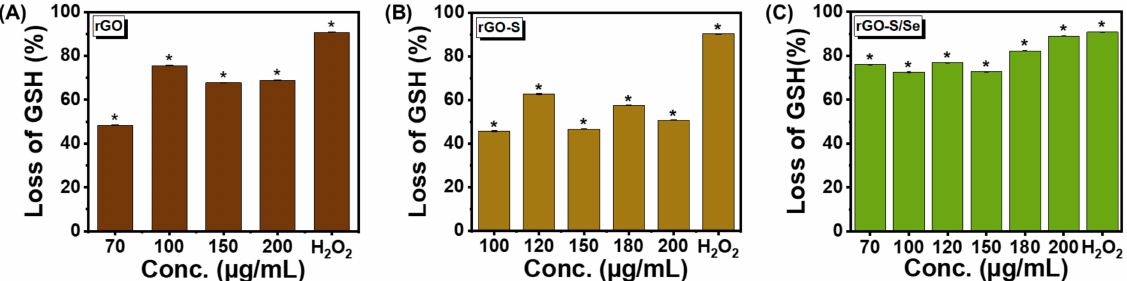
Figure 7. Concentration dependent oxidative stress induced by NPs. Loss of glutathione percent- age after in vitro incubation with the ( A ) rGO; * p -value < 0.05 ( B ) rGO-S; * p -value < 0.005 and ( C ) rGO-S/Se; * p -value < 0.01, at different concentrations ranging from 70 µ g/mL to 200 µ g/mL for 3 h. H 2 O 2 was used as a positive control. Error bar represents standard error of